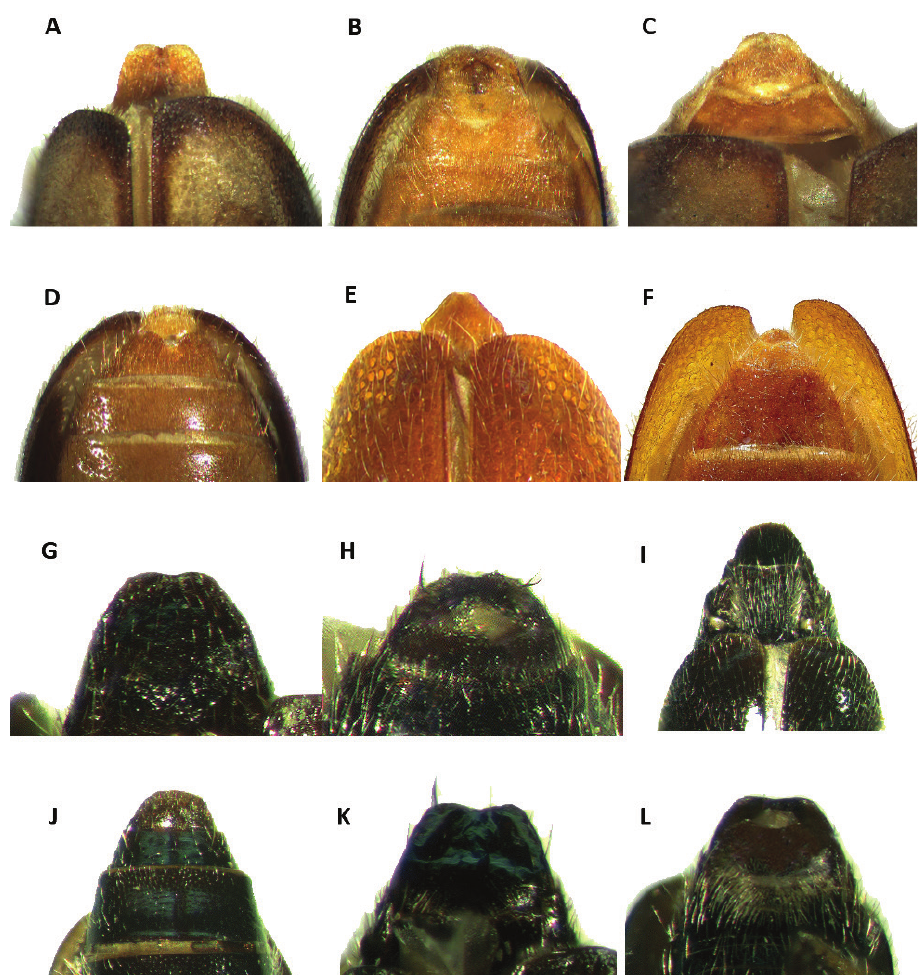
Figure 16. Pygidium of: A Araeodontia peninsularis dorsal (male) B Araeodontia peninsularis ventral (male) C Araeodontia peninsularis dorsal (female) D Araeodontia peninsularis ventral (female) E Bogcia disjuncta dorsal (male) F Bogcia disjuncta ventral (male) G Neocallotillus elegans ( elegans ) dorsal (male) H Neocallotillus elegans ( elegans ) ventral (male) I Neocallotillus elegans ( elegans ) dorsal (female) J Neocal- lotillus elegans ( elegans ) ventral (female) K Neocallotillus elegans ( vafer ) dorsal (male) L Neocallotillus elegans ( vafer ) ventral